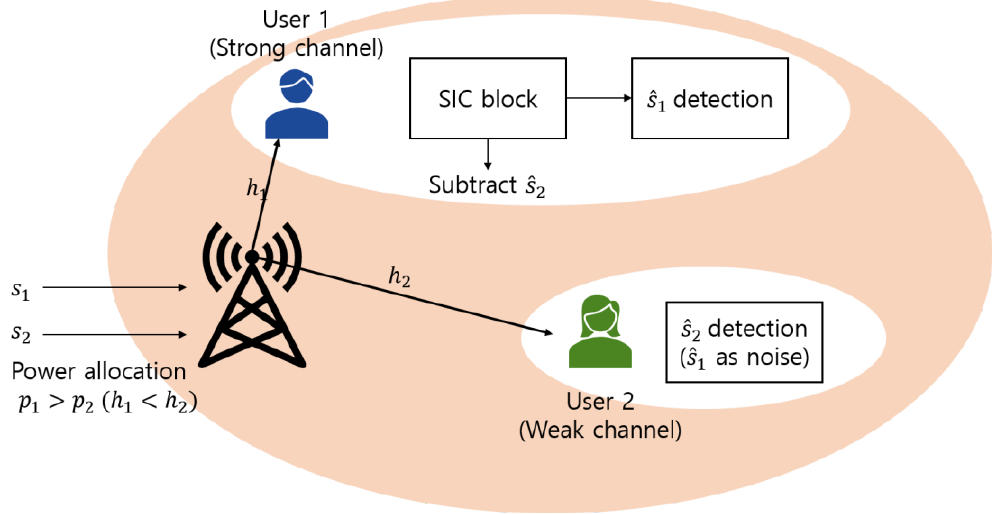
Figure 2. System block diagram of NOMA with a single base station and two users.